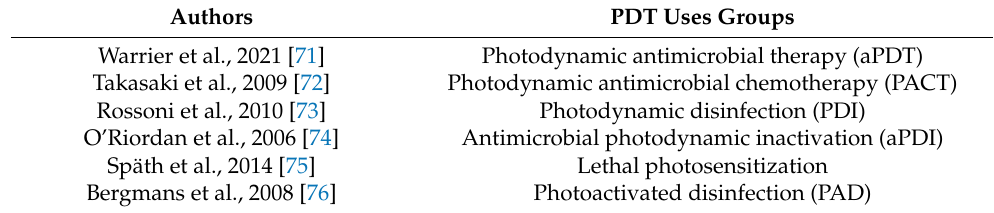
Table 2. The role of PDT in